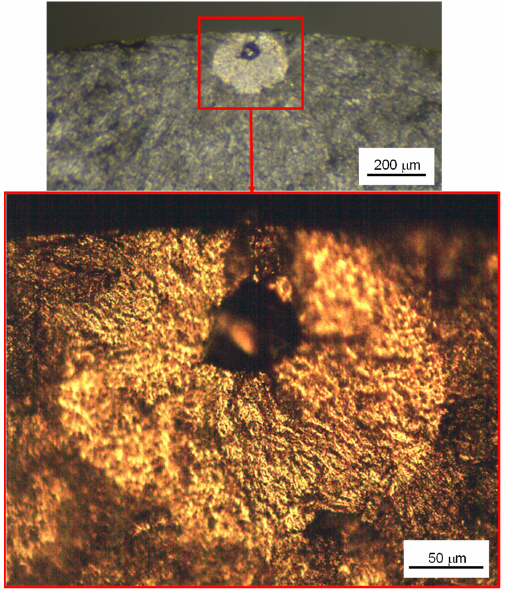
Figure 8. Crack initiation site in a sample of Set HMP-U.